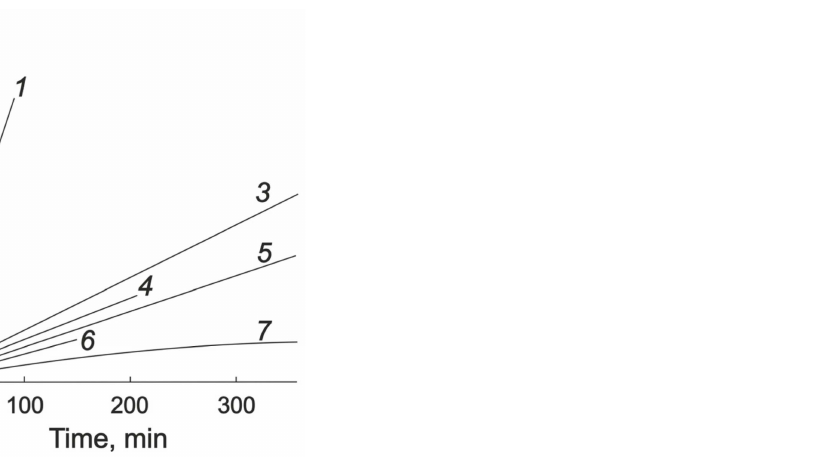
Figure 6. Weight loss ( ∆ m) as a function of run duration of diamonds etched in a basalt melt at 1130 ◦ C and at different f O 2 : 1, 3, 5 = diamonds of fraction 0.6/0.8 mm exposed to air, under HM and NNO buffers, respectively; 2, 4, 6, 7 = octahedral diamonds exposed to air, under the HM, NNO, and CCO buffers, 1200 ◦ C, respectively, complementing